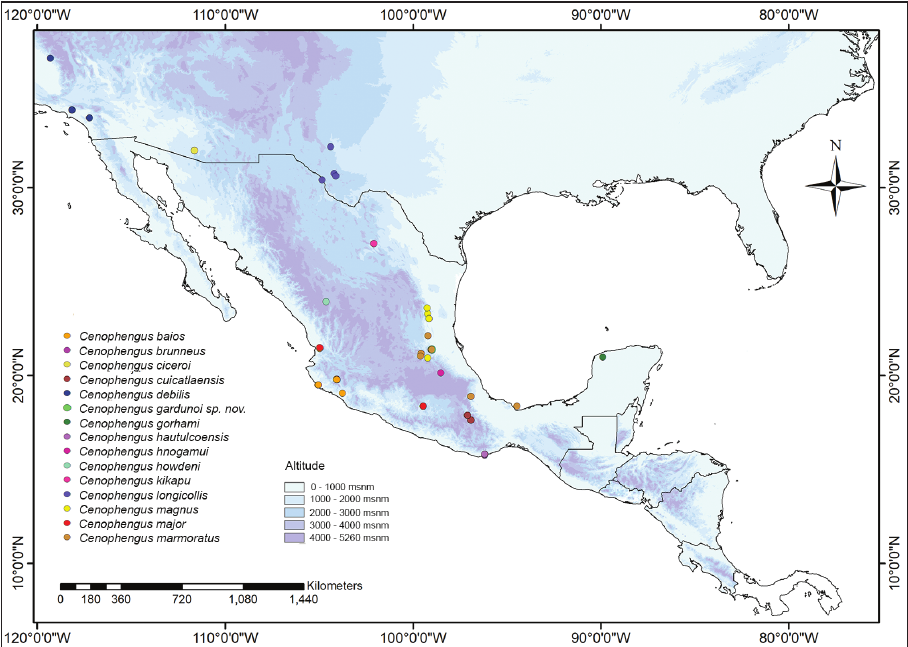
Figure 3. Map of southern North America showing specimen localities for Cenophengus